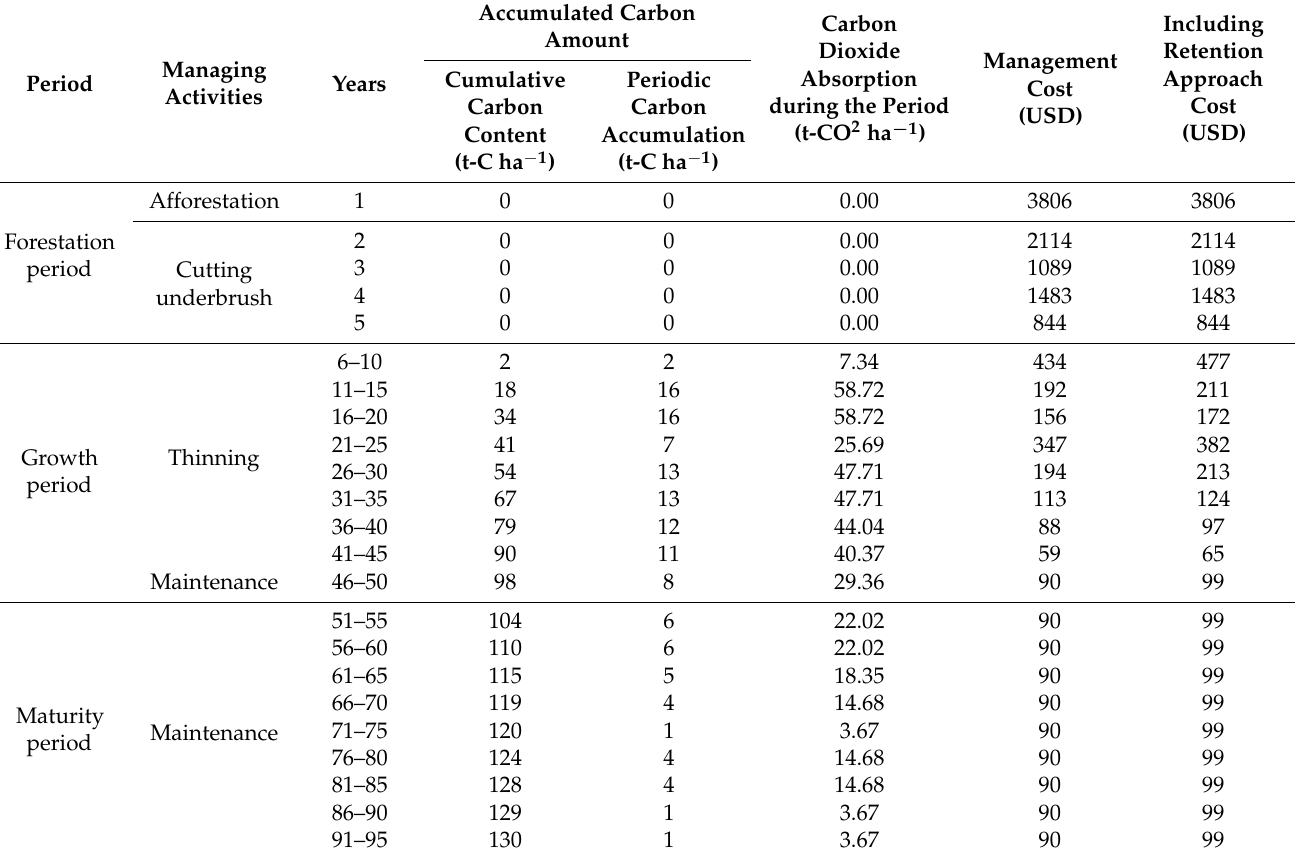
Table 5. Calculation of carbon absorption and management cost by